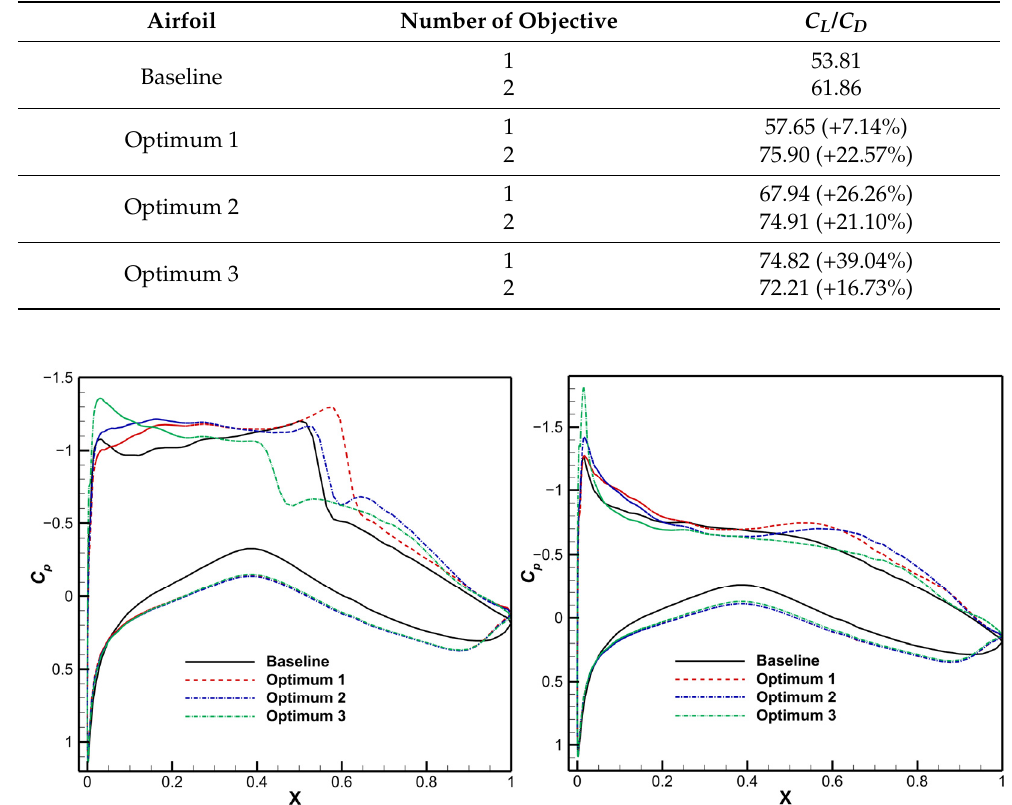
( b4 ) Figure 13. Contour of pressure coefficient comparison between optimized airfoil and baseline: ( a1 ) Baseline of objective 1; ( a2 ) Optimum 1 of objective 1; ( a3 ) Optimum 2 of objective 1; ( a4 ) Optimum 3 of objective 1; ( b1 ) Baseline of objective 2; ( b2 ) Optimum 1 of objective 2; ( b3 ) Optimum 2 of ob- jective 2; ( b4 ) Optimum 3 of objective 2. Furthermore, in order to investigate the acceleration effect of the proposed GMOEGO algorithm in real applications, the aerodynamic airfoil shape optimization case above is also optimized by the counterpart referenced MOEGO algorithm. The computational plat- form is Intel Core i9-9900k CPU (8 cores), and all the other setups remain the same, as mentioned at the beginning of this section. The optimized Pareto fronts obtained by MOEGO and GMOEGO algorithms for comparison is in Figure 14. It can be seen that both algorithms could obtain similar Pareto fronts. Figure 15 shows the comparison of the wall-clock time histories of the two algo- rithms, and the corresponding comparison results are listed in Table 4. The comparison shows that, benefiting from the Monte Carlo-based GPU-acceleration technique, a signif- icantly speedup ratio, up to 7.27 times, is achieved. The fourth column of Table 4 shows